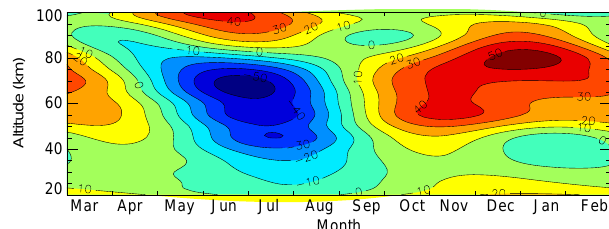
Fig. 11. Zonal wind at Xinglong from December 2009 to November 2010 calculated by the HWM-07 model (averaged from 20:00 to 04:00LT for each